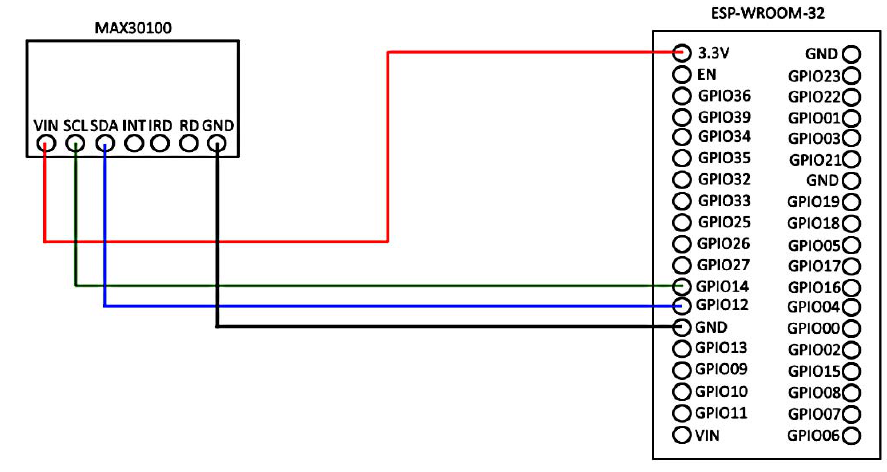
Figure 5. Pin connections of the ESP32 microcontroller.